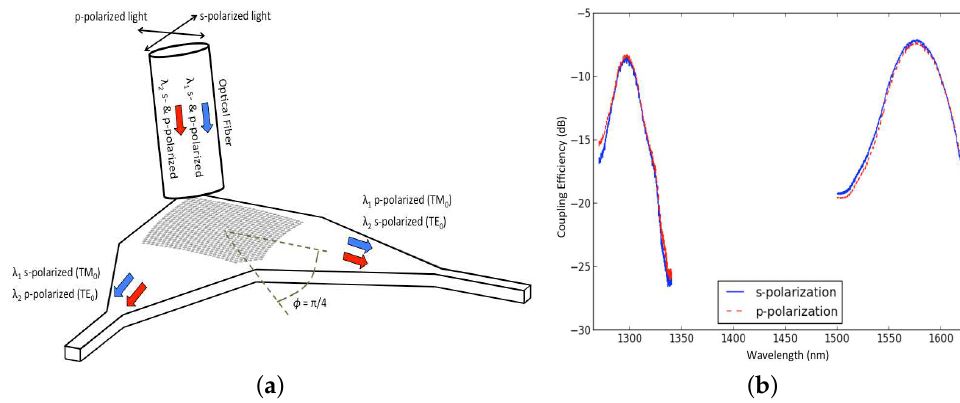
Figure 17. ( a ) Illustration of a 2-D focusing PSGC dual band coupler, where the fiber is oriented along the bisector axis. ( b ) Experimental results for the two bands at different polarization states (Images reprinted with permission from [58]). Table 4. Performance comparison of various SOI based Dual band grating couplers. Here columns 4 and 5 pertain to the polarization state of the coupled waveguide mode in each of the bands.